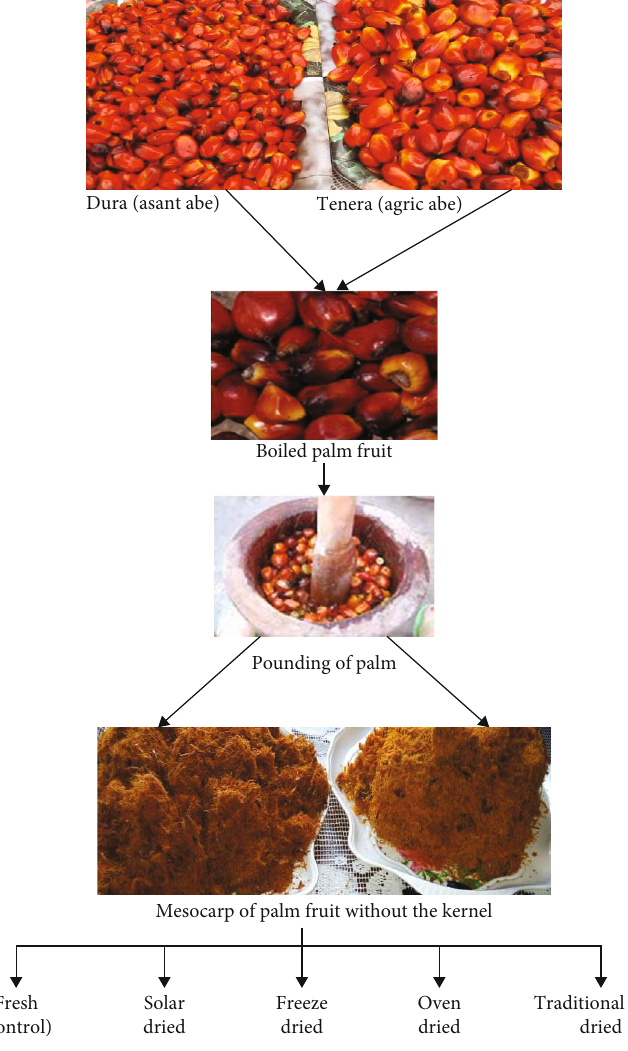
Figure 1: Flowchart for obtaining mesocarp from palm fruit for di ff erent drying